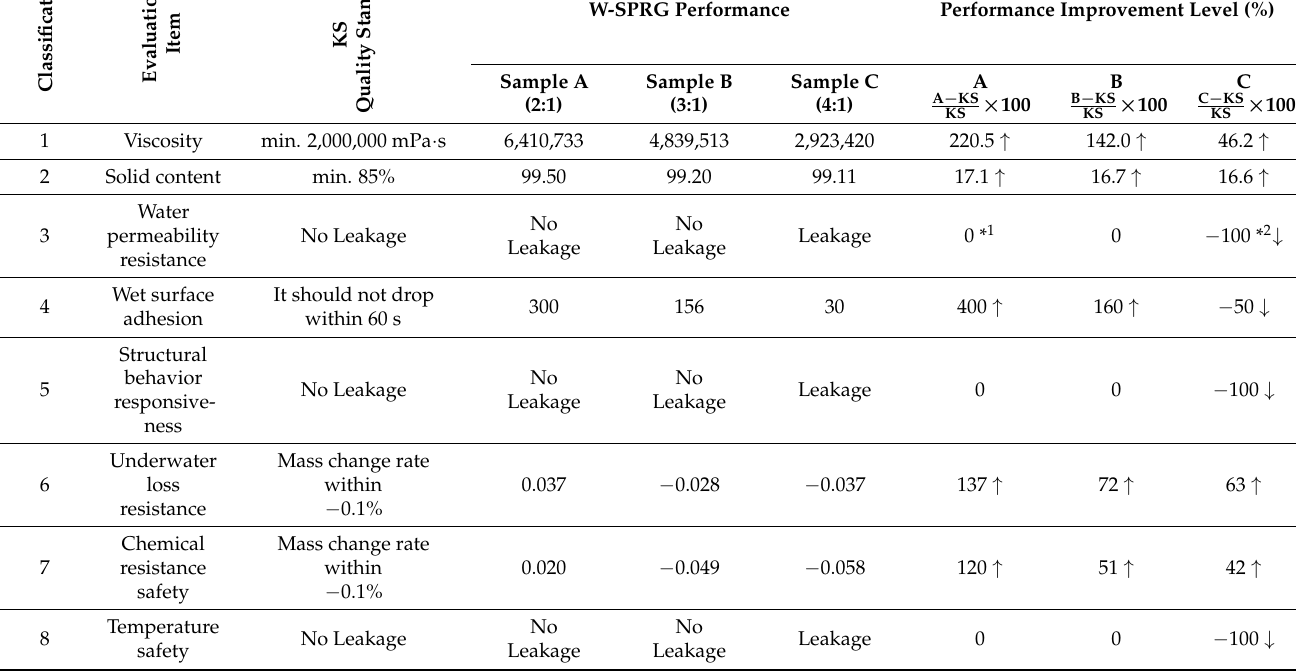
Table 8. Comparative analysis of performance improvement by sample of W-SPRG compared to KS quality